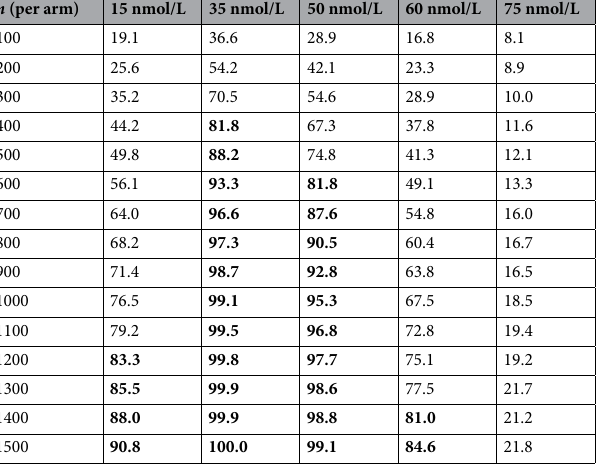
Table 1. Power (in percentage) for 20 nmol/L equivalent dose at u = 2 for a range of sample sizes and baseline population 25OHD concentrations. Designs having ≥ 80% power are in bold